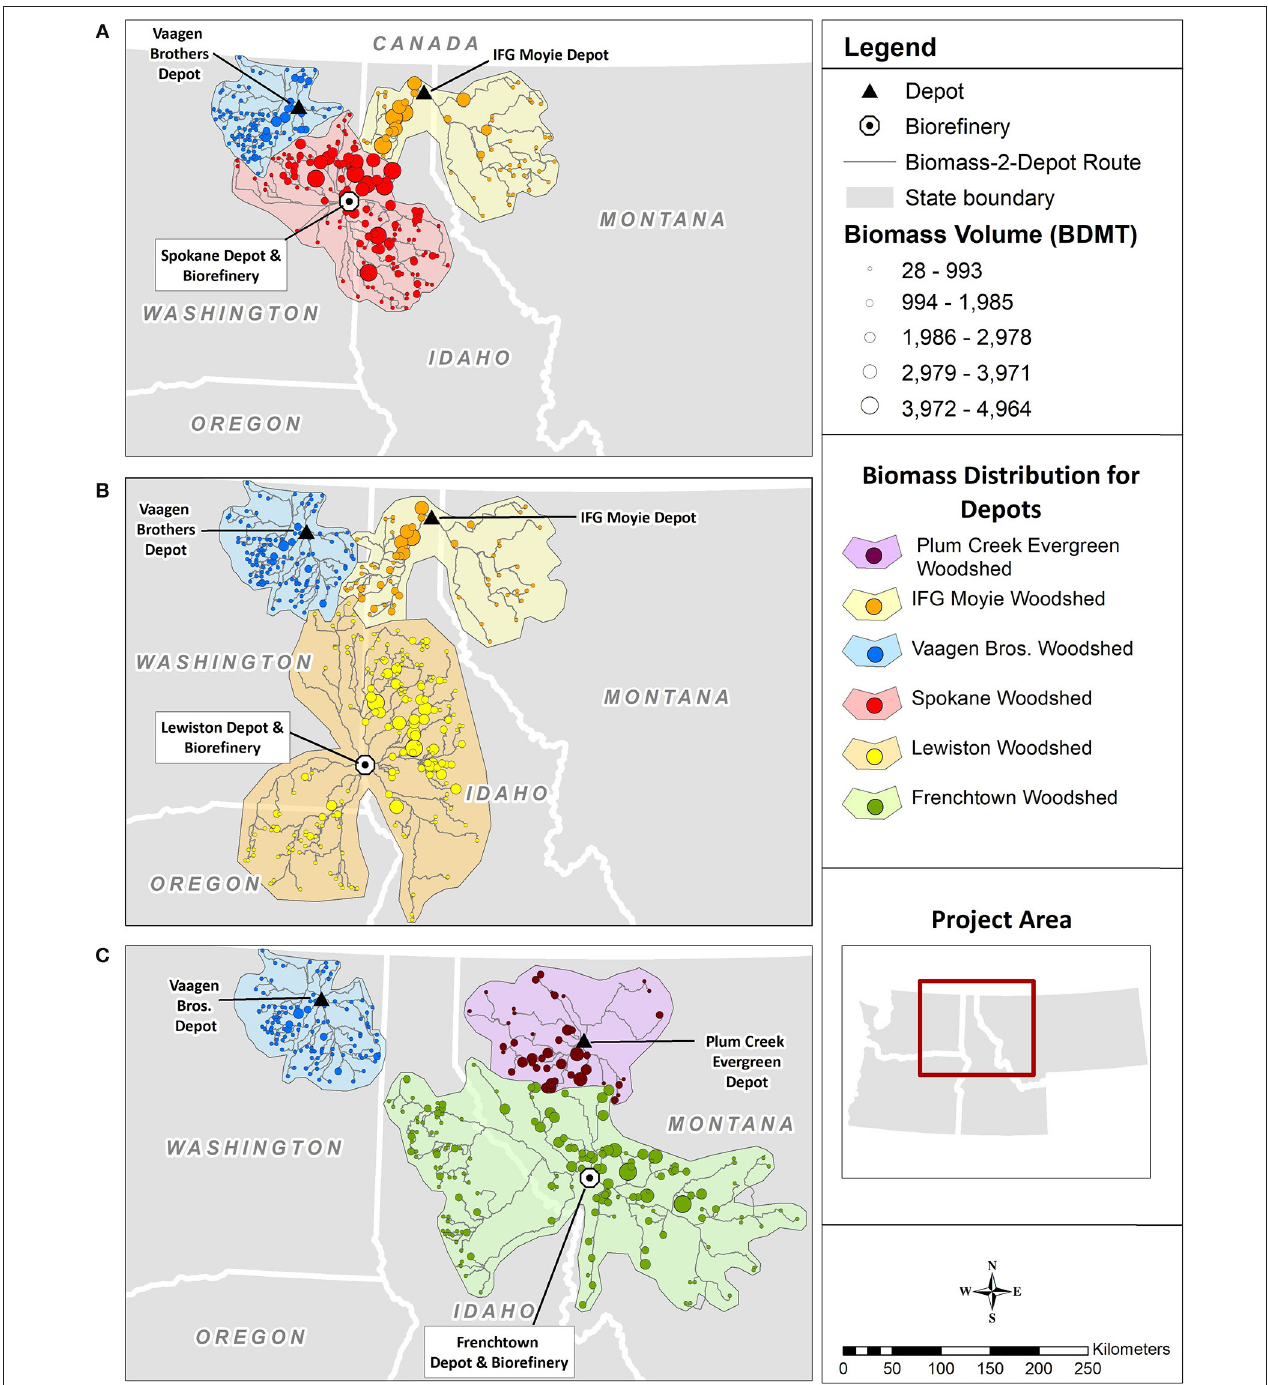
FIGURE 3 | Biomass source point distribution and depot “woodshed” service areas for the (A) Spokane, (B) Lewiston, and (C) Frenchtown biorefinery.